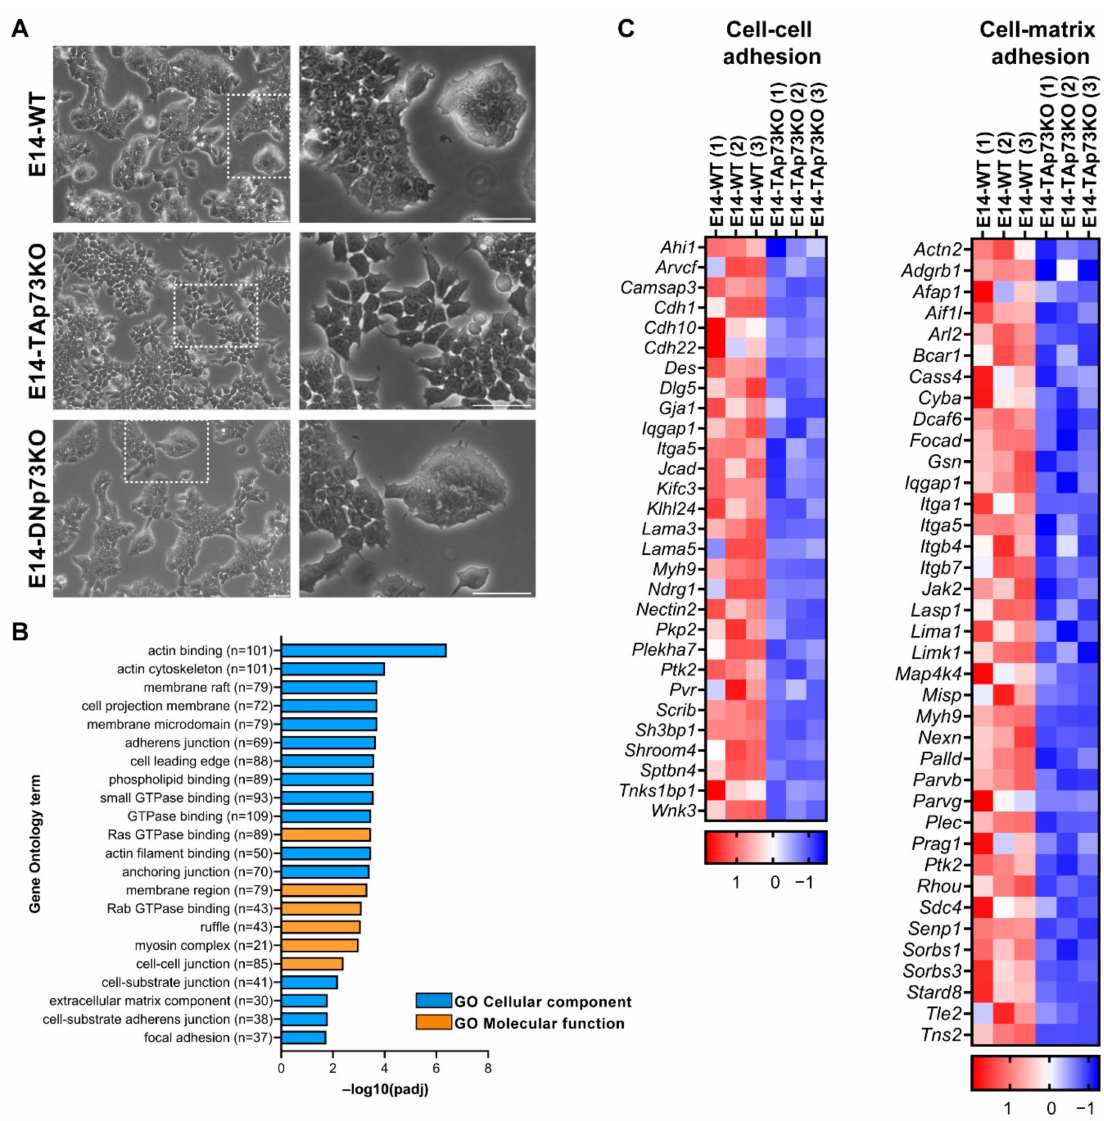
Figure 4. p73 regulates cell adhesion gene networks in mESC. ( A ) Representative images of the three cell lines when seeded under proliferating culture conditions (S/L). The insert represents a magnification from the indicated area (white square). Scale bar: 250 µ m. ( B ) Gene Ontology (GO) analysis for downregulated genes in E14-TAp73KO samples compared to E14-WT controls. The number of genes for each term is indicated. ( C ) Heatmaps of down-regulated DEGs in E14-TAp73KO vs. E14-WT under stemness conditions. The cell-cell adhesion heatmap includes the DEGs in common among the GO categories “adherens junction”, “anchoring junction” and “cell-cell junction” from ( B ). Likewise, the cell-matrix adhesion heatmap contains the overlapping genes from the categories “cell-substrate junction” and “focal adhesion”. RNA-Seq expression Z-scores for each gene are